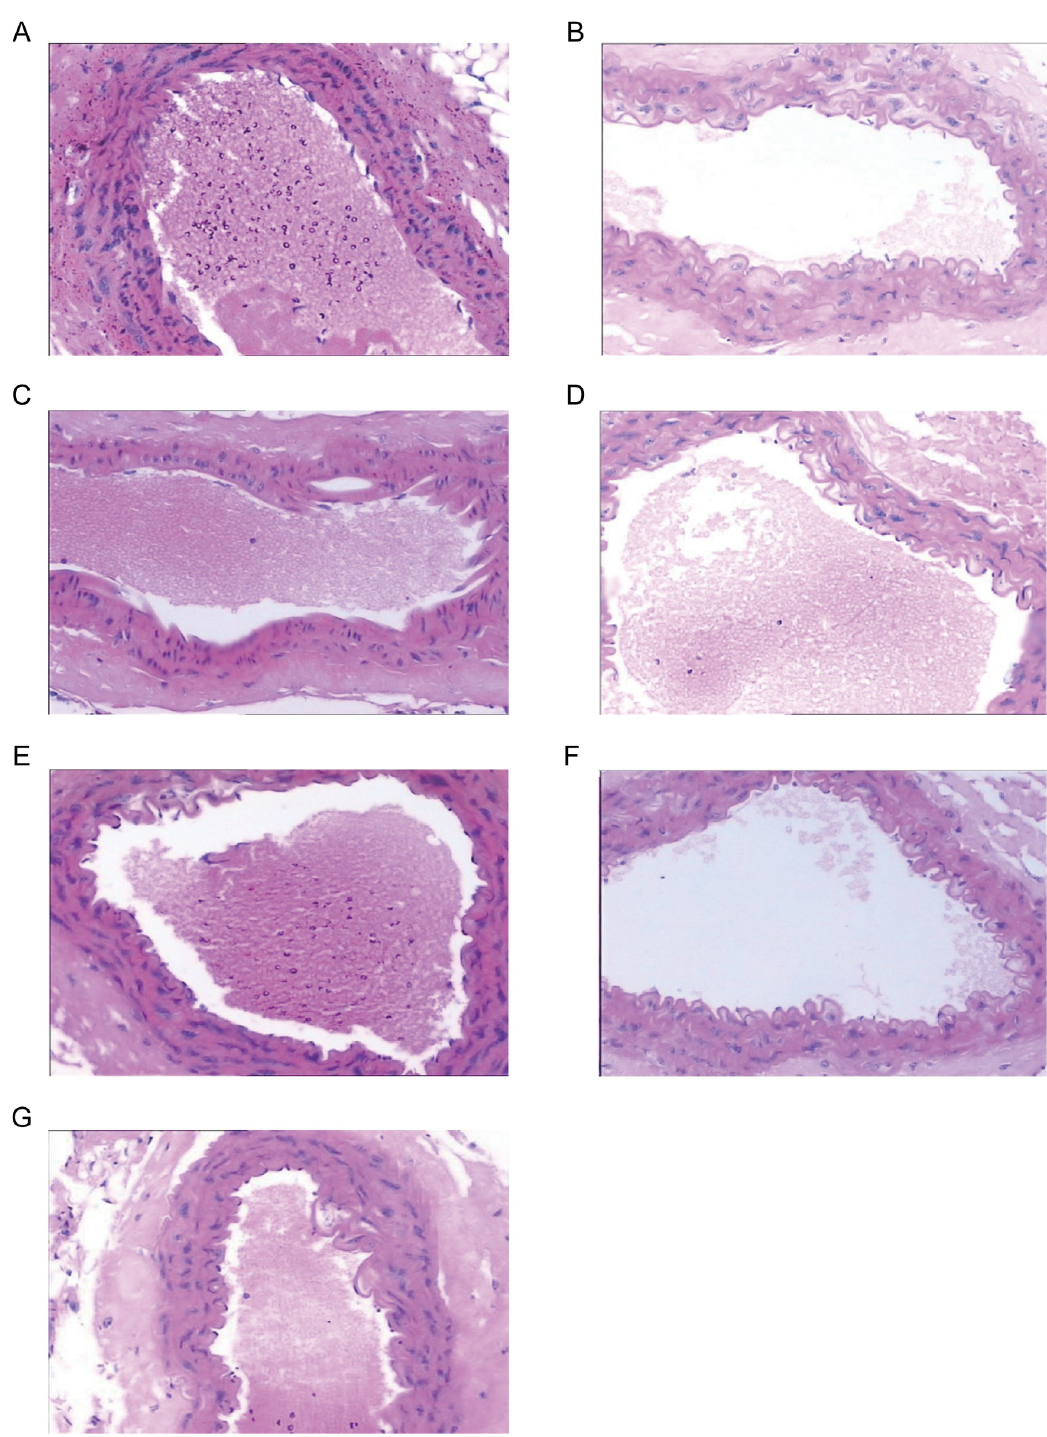
Fig 1. Pathological morphology comparison. (A) Images of abdominal aortic intima pathology in healthy C57BL/6J mice. The vascular endothelial cells are flat and closely attached to the flat inner elastic plate. The medium elastic plate and the vascular smooth muscle cells are arranged in parallel and the inner membrane is smooth and tidy. (B) KKAy Pathological section imaging of vascular endothelial cells in spontaneous diabetic mice. The vascular endothelial cells showed swelling and no obvious endothelial cell shedding. (C) Pathological section imaging of abdominal aortic endothelial cells in diabetic macroangiopathy group. The abdominal aortic endothelial cells showed high edema, large area and continuous flaking, and the intima was not